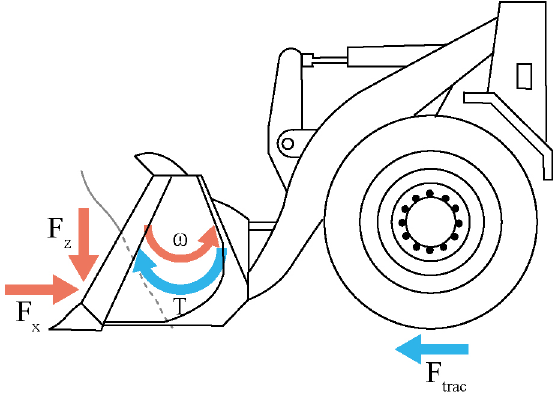
Figure 11. Schematic picture of the forces of the